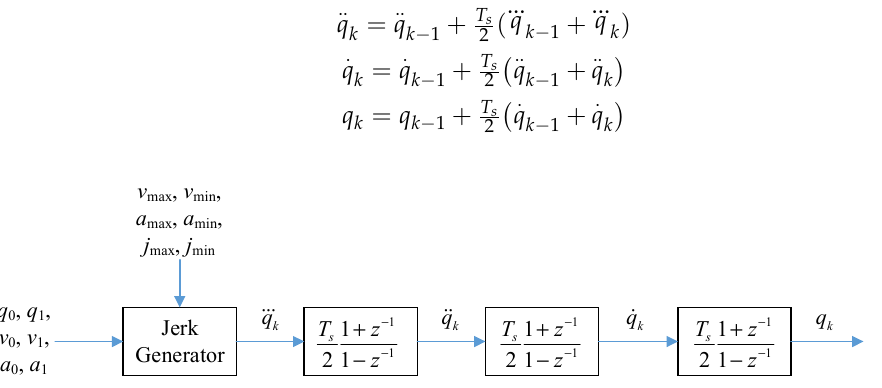
Figure 11. Block diagram of the trajectory planner.